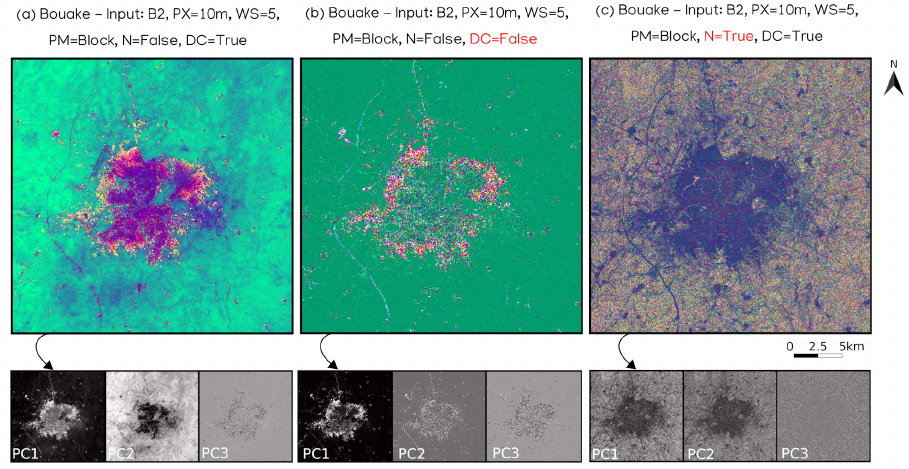
Figure 6. Influence of the dc component and the normalization parameters in the FOTOTEX algorithm for the characterization of urban areas at the macro-scale using Sentinel 2 images on Bouake. ( a ) B2 (blue) sentinel 2 band on Bouake with DC component (DC = True) and without normalization (N = False), ( b ) B2 (blue) sentinel 2 band on Bouake without DC component (DC = False) and without normalization (N = False) and ( c ) B2 (blue) sentinel 2 band on Bouake with DC component (DC = True) and normalization (N = True). The text in red highlights the modified parameter compared with image ( a ). (PX = pixel size, WS = window size, PM = partitioning method, DC = DC component, N =